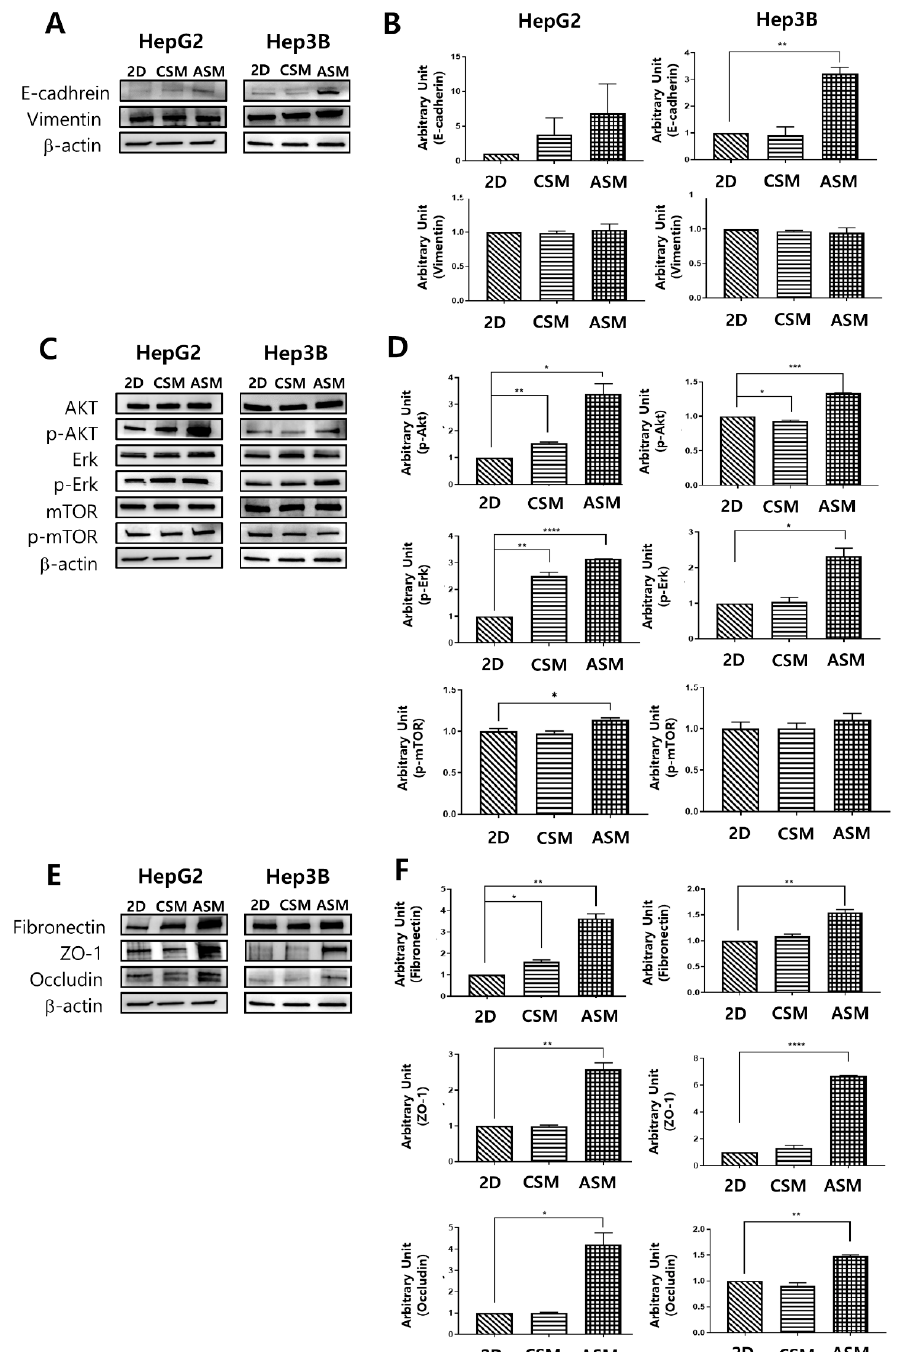
Figure 3. Western blot analysis of epithelial cell protein and cell proliferation receptor protein expression. Changes in the expression level of the epithelial cell protein ( A , B ), proliferation receptor protein ( C , D ), ECM/ Cell tight junction protein ( E , F ) as determined by western blot analysis. Increased expression of E-cadherin, p-AKT, p-Erk, Fibronectin, ZO-1, and Occludin under ASM culture conditions. All factors were normalized to β -actin. * p < 0.05, ** p < 0.01, *** p < 0.001, **** p < 0.0001.